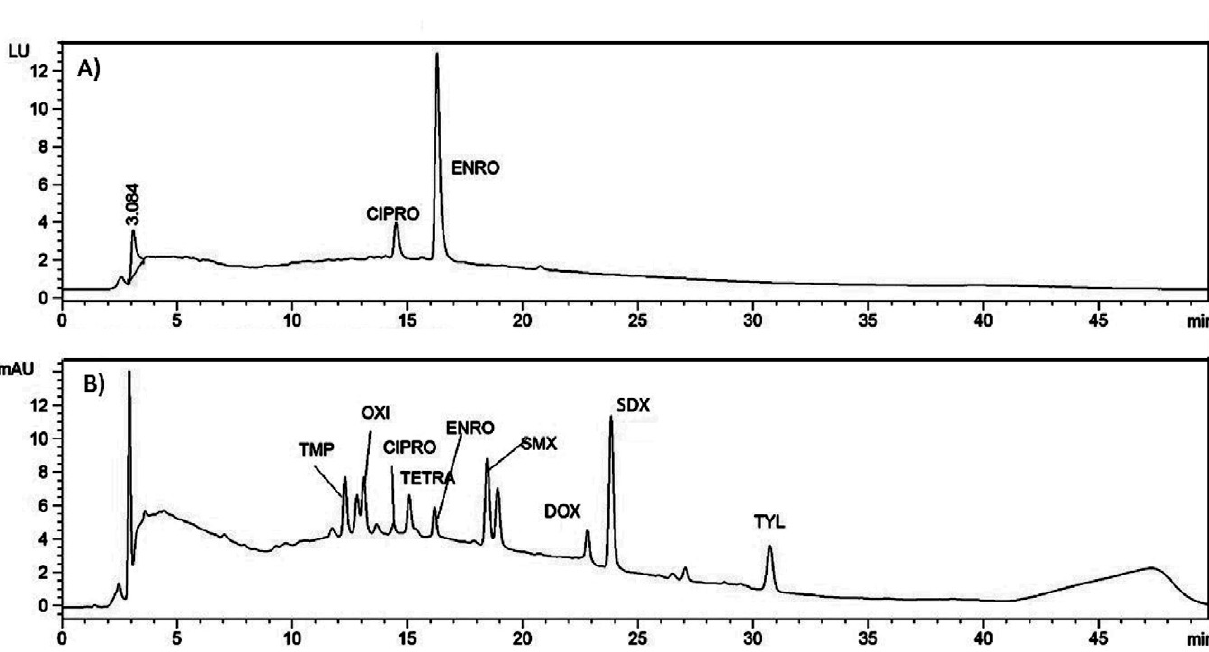
Figure 3 . Chromatogram of the mixture of added antibiotics in river water. (A) fluorescence detection (λ ex 278nm and λ em 450 nm) (B) UV detection 280 nm. Conditions of analysis are described in the text.